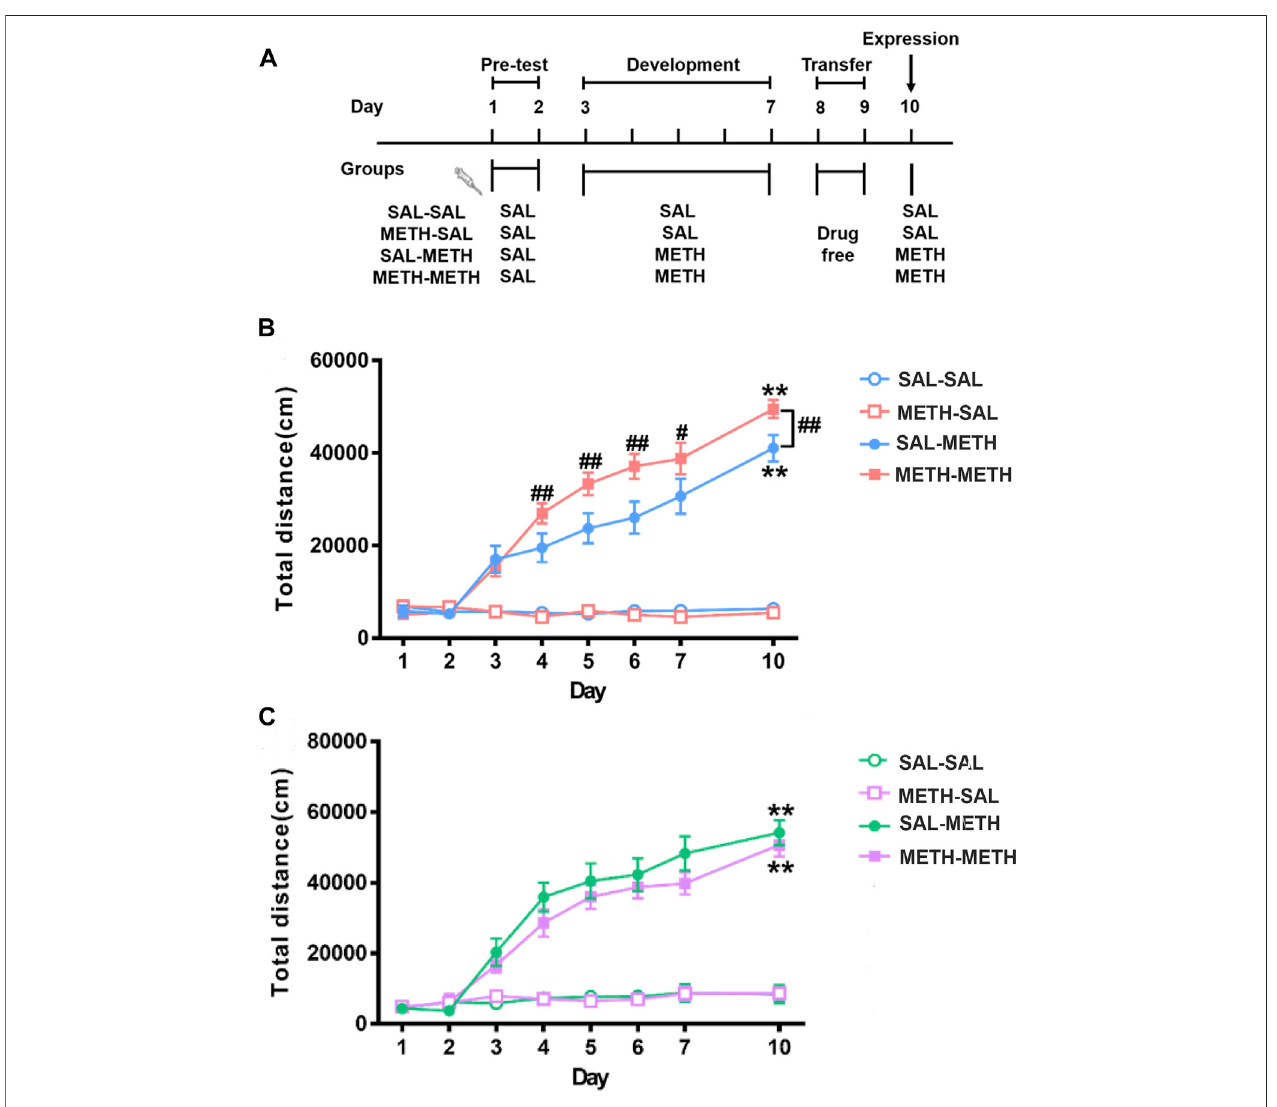
FIGURE 2 | Maternal METH exposure enhanced METH-induced behavioral sensitization in F1 adult male progeny. (A) Schematics of METH-induced locomotor sensitization. (B) METH- METH male mice developed an earlier locomotor sensitization and exhibited hyper-locomotor activity compared with SAL-METH males. (C) METH-METH female mice developed a trend of reduced behavioral sensitization compared with SAL-METH females. Two-way repeated measures ANOVA with a post hocmultiplecomparisonswasused.** p < 0.01comparedwithday3;# p < 0.05,## p < 0.01comparedwithSAL-METHgroup.Dataarepresentedasmean±SEM (each group n = 8). Abbreviations: SAL-SAL, prenatal and postnatal saline exposure; METH-SAL, prenatal METH and postnatal saline exposure; SAL-METH, prenatal saline and postnatal METH exposure; METH-METH, prenatal and postnatal METH exposure.